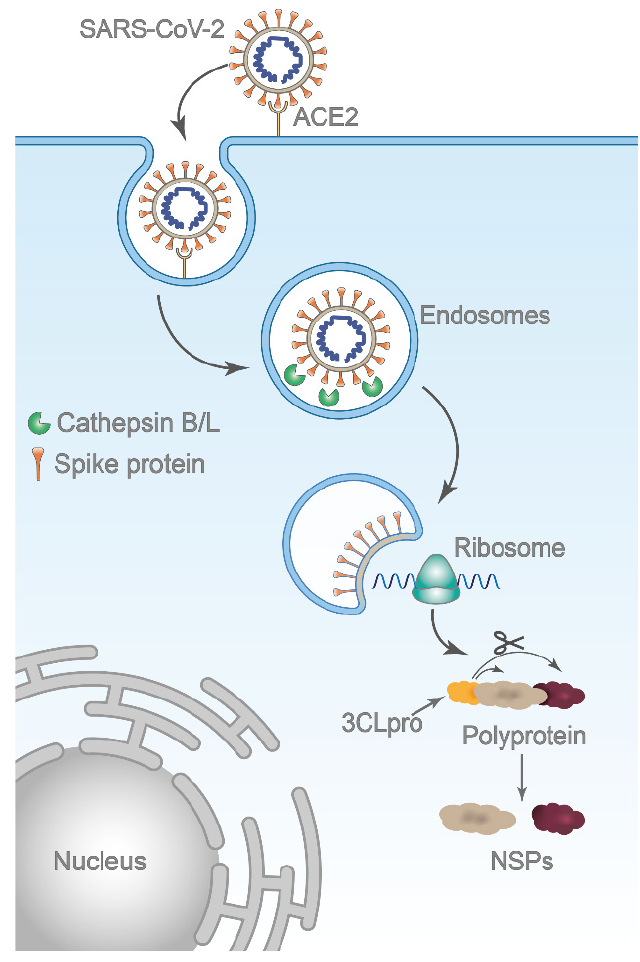
Figure 1. Schematic representation of SARS-CoV-2 entry by the endosomal route. After binding to its host receptor angiotensin-converting enzyme 2 (ACE2), the virus is internalized via endocytosis. The low pH within the endosome activates Cat L, which in turn triggers membrane fusion by proteolytic cleavage of the S protein. Upon membrane fusion, viral genomic RNA is released in the cytoplasm and initiates translation of polyproteins, which is, subsequently, cleaved into nonstructural proteins (NSPs) by viral main protease 3CLpro. Several NSPs constitute the replicase–transcriptase complex essential for viral replication.